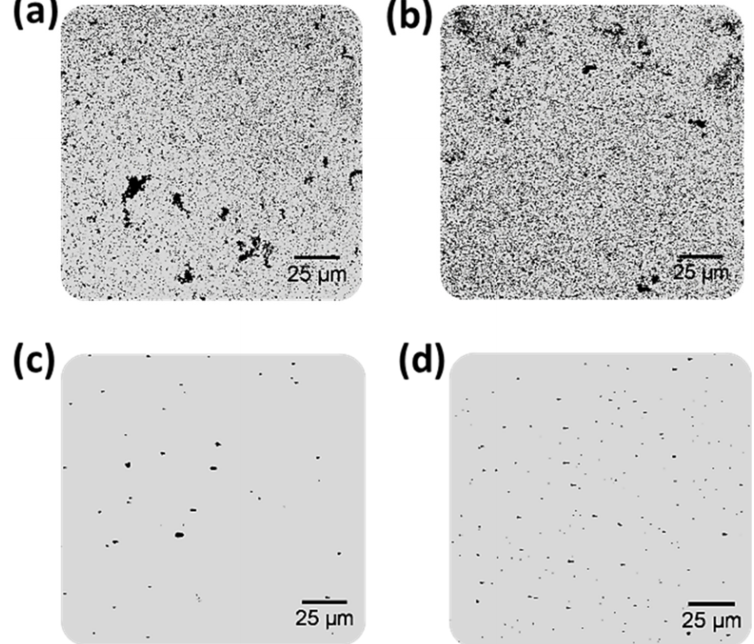
Figure 2. Confocal microscopy images of small areas (160 × 160 μ m 2 ) of the microscopy slide wells obtained after the immunoassay followed by gold deposition on the antibody labels (Mn ‐ ZnS quantum dots (QDs) and gold nanoparticles (AuNPs)) at different PSA concentrations. ( a , b ) dots (QDs) and gold nanoparticles (AuNPs)) at di ff erent PSA concentrations. ( a , b ) Amplified AuNPs, Amplified AuNPs, 0 and 100 pg ∙ mL − 1 PSA, respectively; ( c , d ) amplified QDs, 0 and 100 pg ∙ mL − 1 PSA, 0 and 100 pg · mL − 1 PSA, respectively; ( c , d ) amplified QDs, 0 and 100 pg · mL − 1 PSA, respectively.